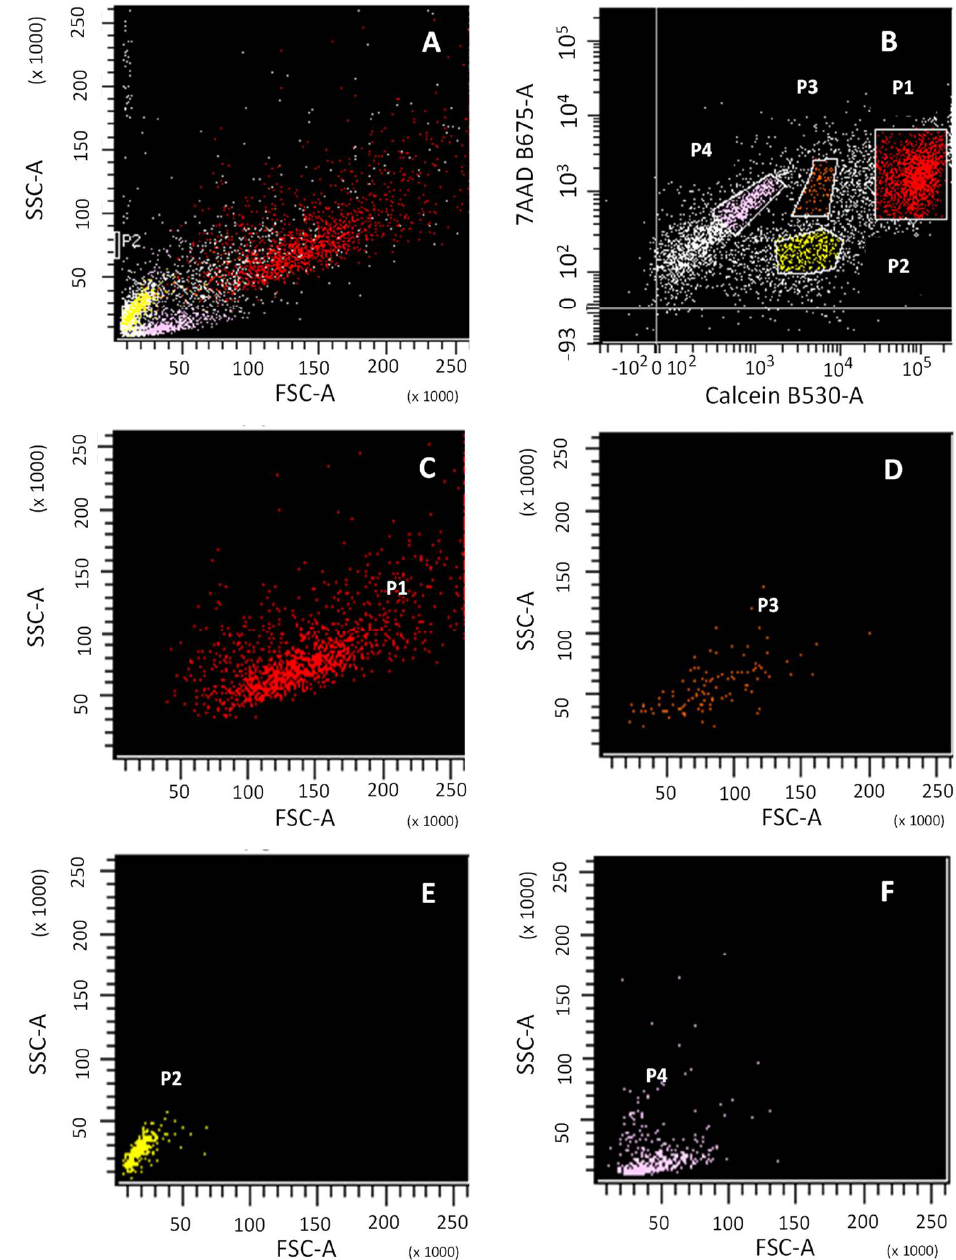
Figure 1. Flow cytometry analysis of cell viability of digested cartilage. Cell size (FSC) vs. cellular complexity (SSC) signals of the total population of: total cartilage digested ( A ); sub-population P1 of viable cells, calcein+ ( C ); sub-population P3 of viable cells, calcein+ ( D ); sub-population P2, calcein- ( E ); sub-population P4, calcein- ( F ). Calcein and 7-AAD signal of the total population ( B ). P1 and P3 populations (Figure 2C) are thus considered living cells, because (i) both FSC/SSC plots show a cell size pattern, although P3 has a smaller cell size than P1; (ii) the populations are calcein positive, although P3 incorporates less calcein than P1. However, populations, the FSC/SSC plot shows small particles that are not within the cell cycle, as indicated by their negative Ruby